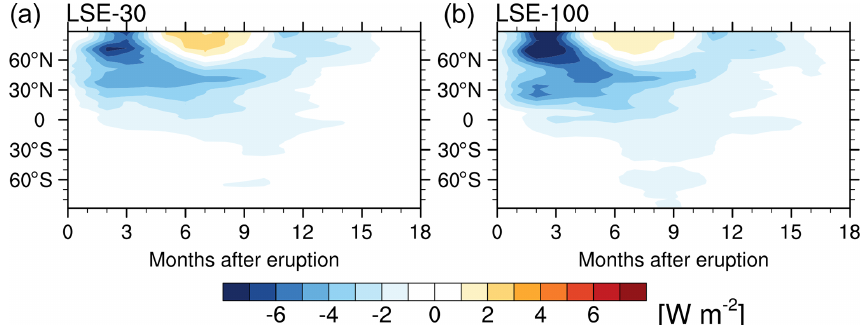
Figure 10. Hovmøller diagram of zonally averaged radiative forcing (all sky, top of atmosphere) of sulfate aerosols of the LSE-30 (a) and LSE-100 (b) scenarios.